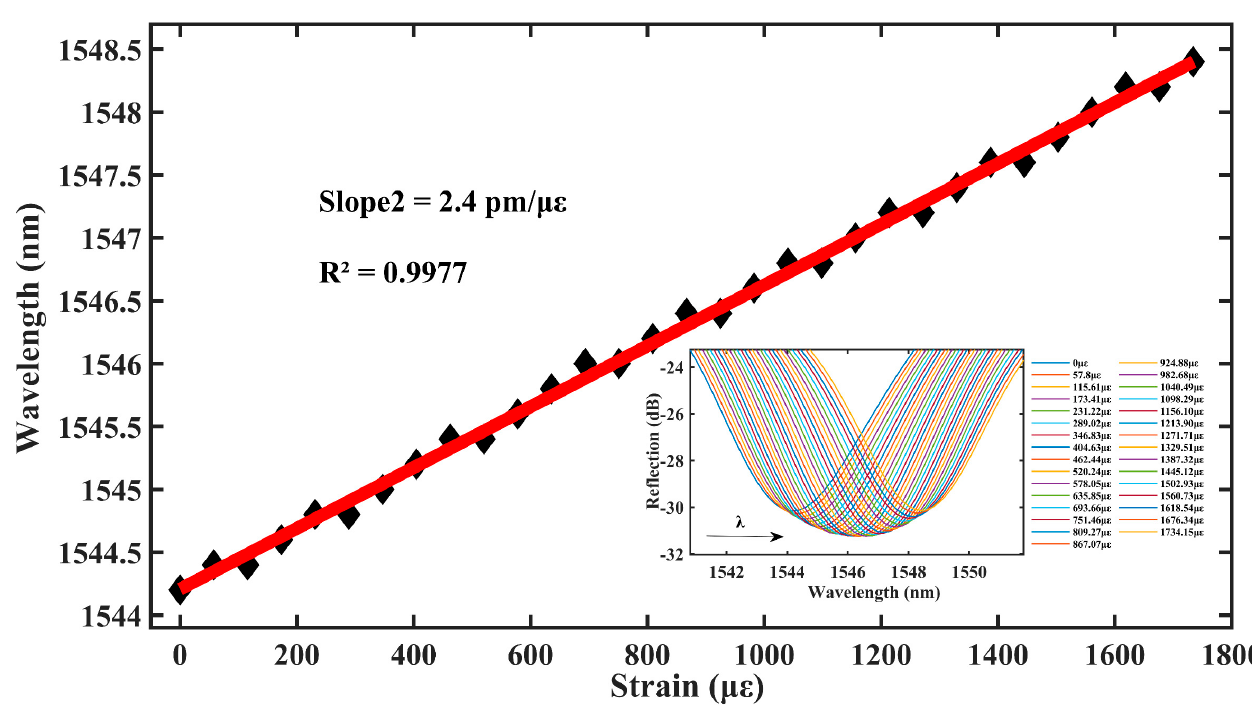
Figure 6. Double bubble strain drift and fit plots before magnification.